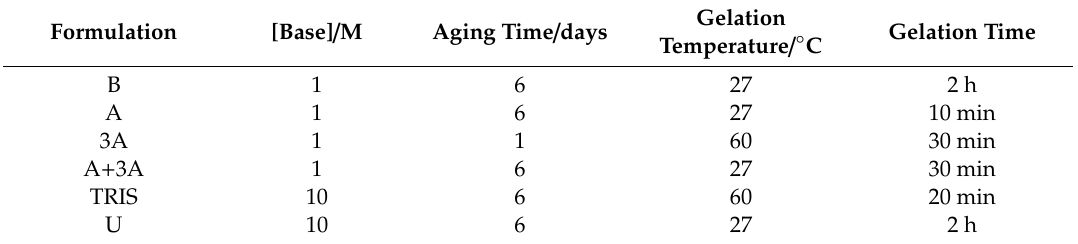
Table 8. Summary of the adjusted condensation / gelation conditions for the synthesis of aerogels and